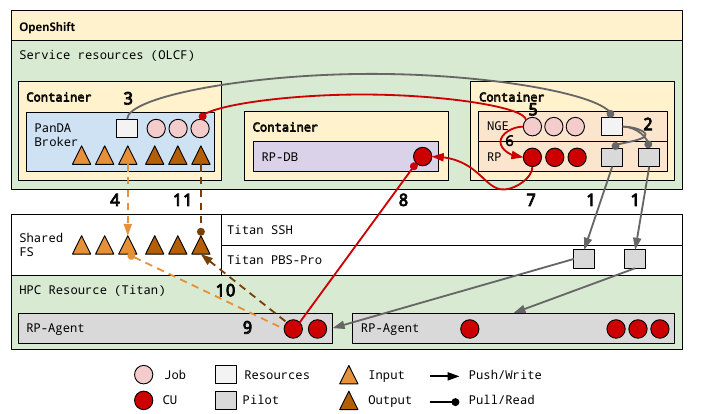
Figure 3: Integration between Harvester and NGE deployed at OLCF to manage the execu- tion of Particle Physics and Molecular Dynamics workloads. Harvester, NGE and RP, and MongoDB are deployed on containers provided and managed via